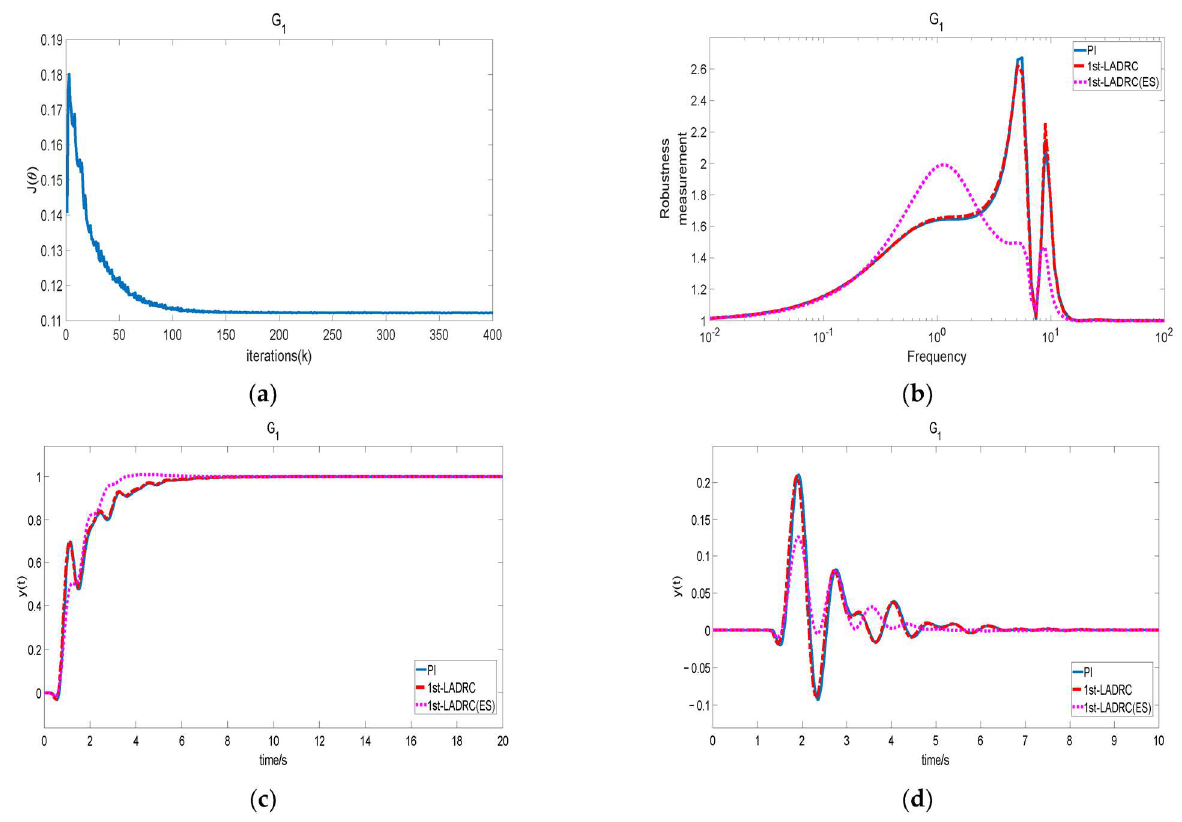
Figure 7. ( a ) Evolution of the cost function; ( b ) robustness of the controllers; ( c ) output signal; ( d ) disturbance responses during experiments of a closed-loop system with G 1